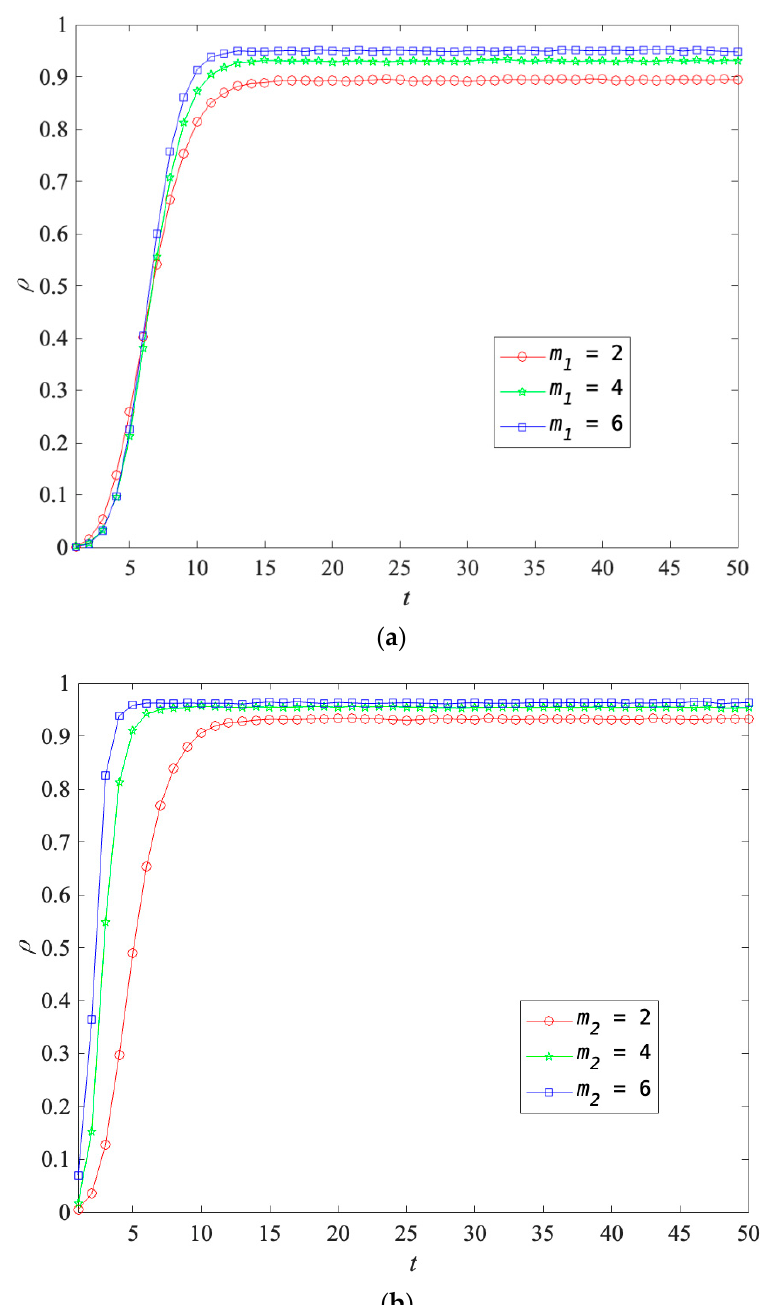
Figure 8. The simulated density of infected nodes ρ vs. time t for different numbers of new nodes m 1 ( a ) and old nodes m 2 ( b ).